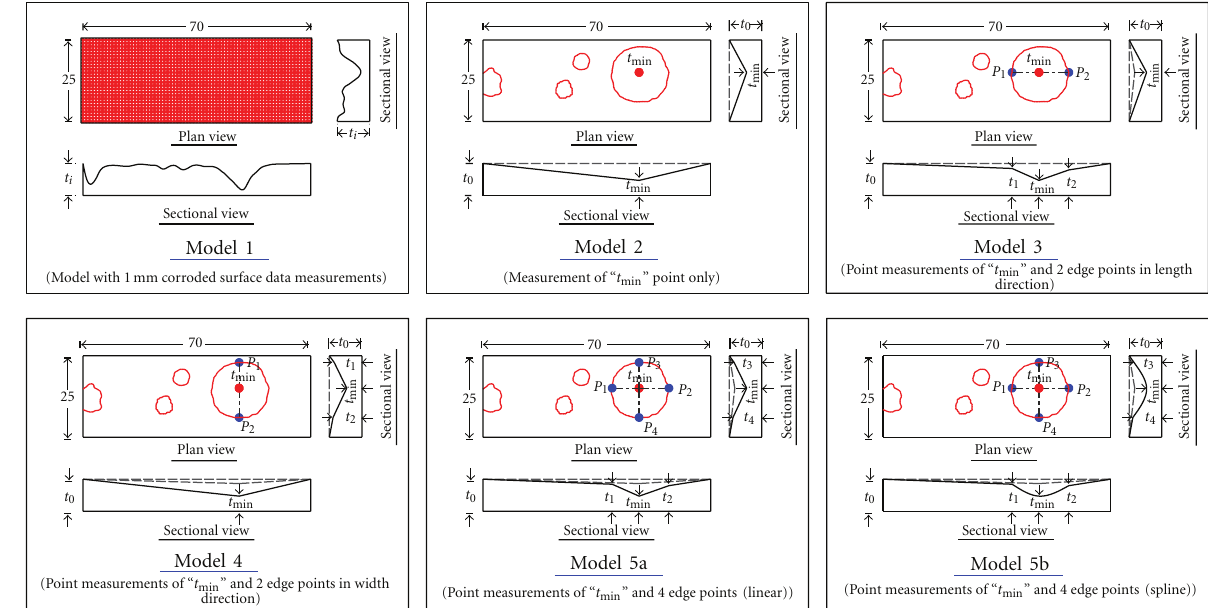
Figure 11: SCSM analytical models.